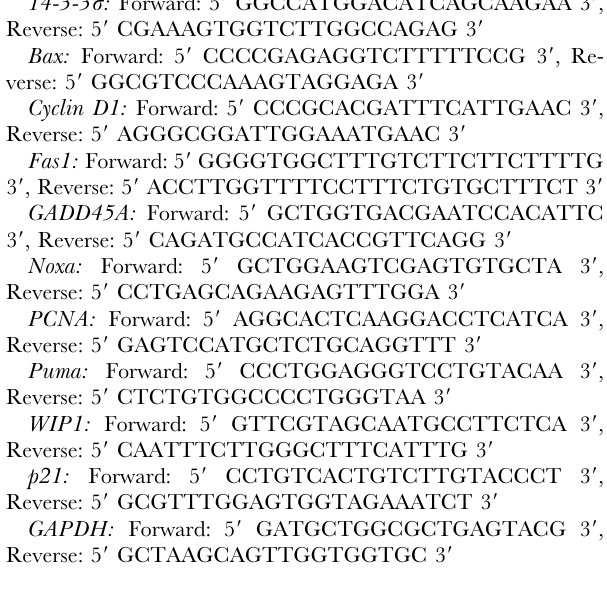
Figure S1 Myc-tagged MDM2-ALT1 and MDMX-ALT2 co- immunoprecipitate with endogenous full-length MDM2 and MDMX. Myc-tagged LacZ, GFP, MDM2-ALT1 or MDMX- ALT2 were immunoprecipitated using anti-myc tag antibody. The immunoprecipitated proteins were separated using SDS-PAGE and probed for A . endogenous MDM2 using SMP14 anti-MDM2 antibody. The lower panel confirms the over-expression of myc tagged proteins in the total cell lysate and also the immunoprecip- itation of the myc-tagged proteins via anti-myc tag western blot. B . Myc tagged MDM2-ALT1 and MDMX-ALT2 co-immunoprecip- itate with full-length MDMX (immuno blot using MDMX A300- 287A antibody) but not myc-GFP or LacZ. The dashed boxes indicate the regions cropped in Figure 1C and 1D. Confirmation of